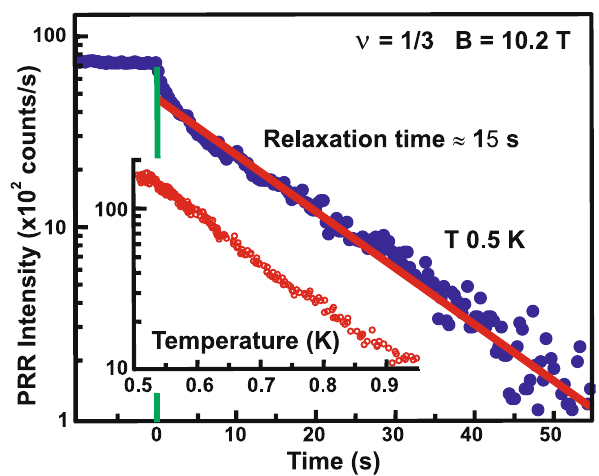
Fig. 6 Relaxation time for the neutral excitations. Dependence of the amplitude of photoinduced resonant re fl ection signal (at 1.5332 eV energy of the scattered photons) on the time duration after the turn-off of the fi rst radiation source (with 1.537 eV photon energy of pumping radiation) employed to create excitations in the electron system (blue dots). Green line indicates the moment of shutting down the exciting beam. Red line is a linear approximation on a logarithmic scale. The inset shows a photoinduced resonant re fl ection intensity as a function of temperature, given the fi xed power levels of both radiation sources. The signal of photoinduced resonant re fl ection vanishes approximately at the same temperature as when the Laughlin state ν = 1/3 is